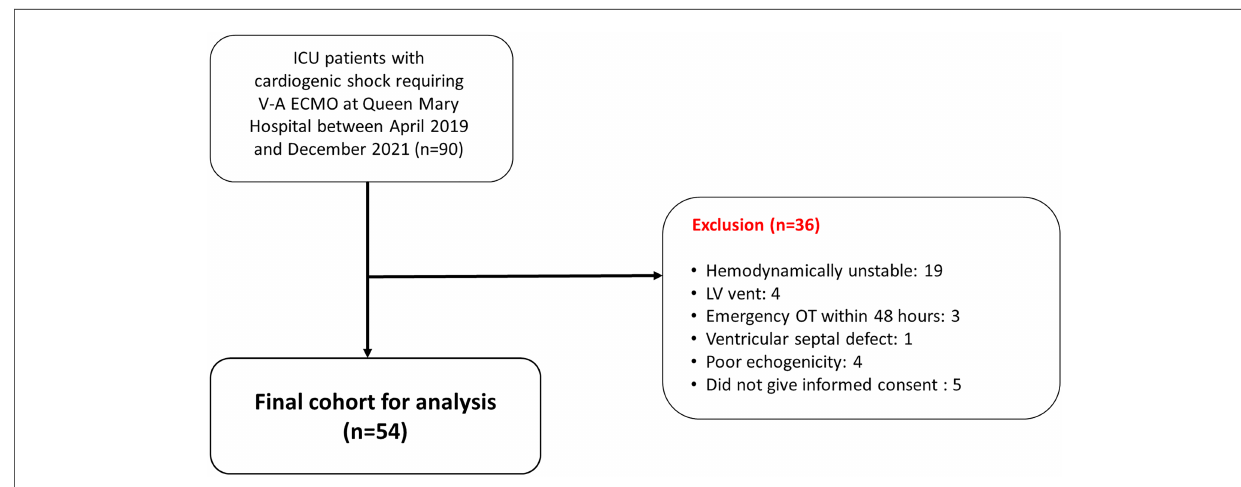
FIGURE 1 Flow diagram of the study. A total of 90 adult patients were admitted to the intensive care unit with a diagnosis of cardiogenic shock requiring V-A ECMO support between 1st April 2019 and 31st December 2021. After excluding 36 patients, the fi nal patient cohort consisted of 54 patients. ICU, intensive care unit; LV, left ventricular; OT, operation; V-A ECMO, veno-arterial extracorporeal membrane